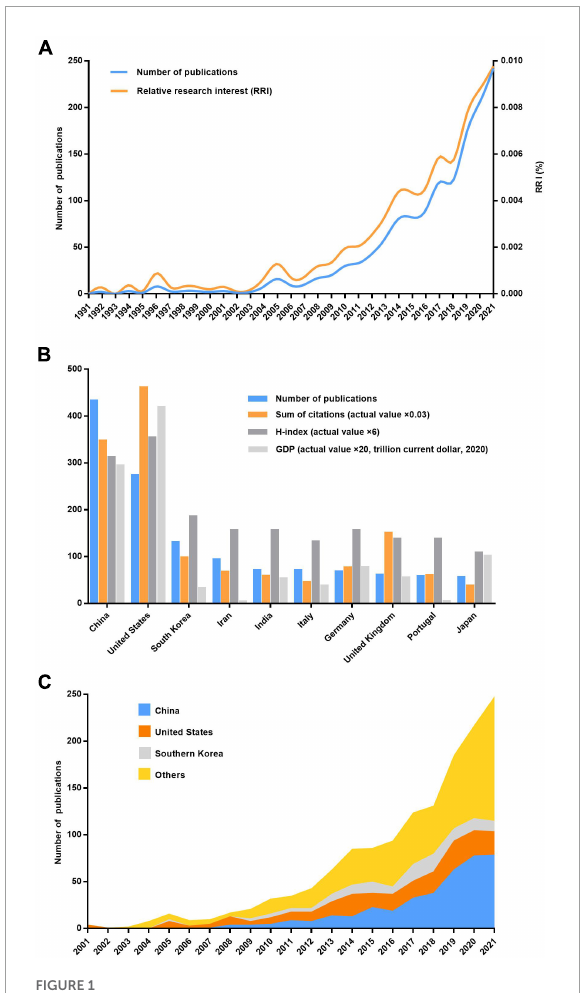
FIGURE1 Contributions of different countries/regions to the field of skin regeneration. (A) Number of publications worldwide and the time course of relative research interest in skin regeneration; (B) number of publications, citation frequency ( × 0.03), H-index ( × 6), and GDP ( × 20, per trillion US dollars, 2020) of countries/regions (no less than five publications regarding skin regeneration); (C) number of publications from the top three and other countries per year (RRI, relative research